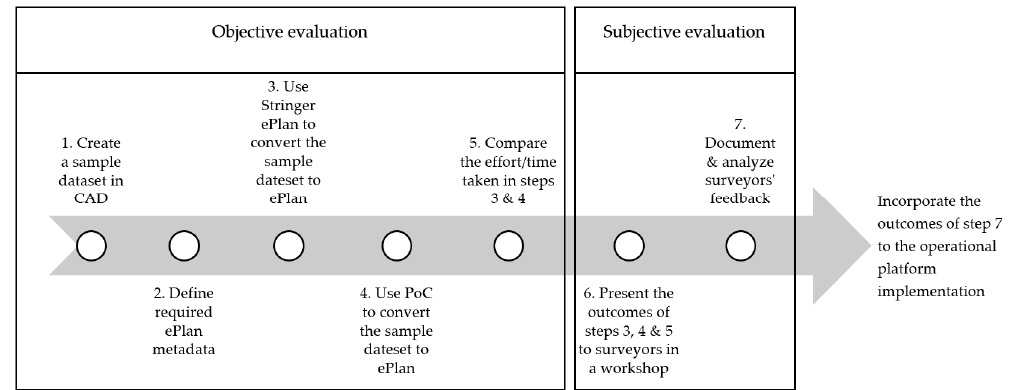
Figure 7. Mixed evaluation approach used in this study.